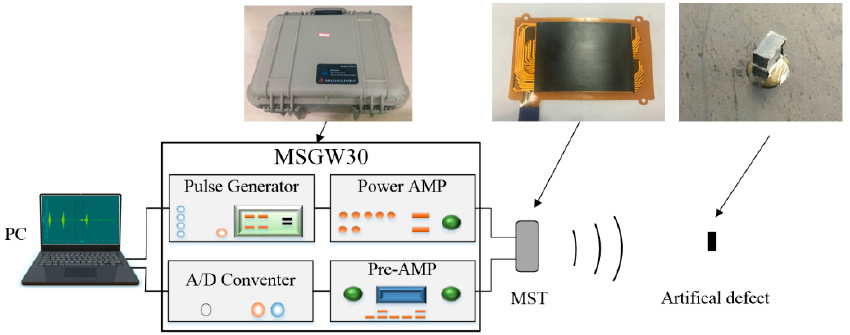
Figure 13. The magnetostrictive guided wave inspection system for circumferential scanning in the